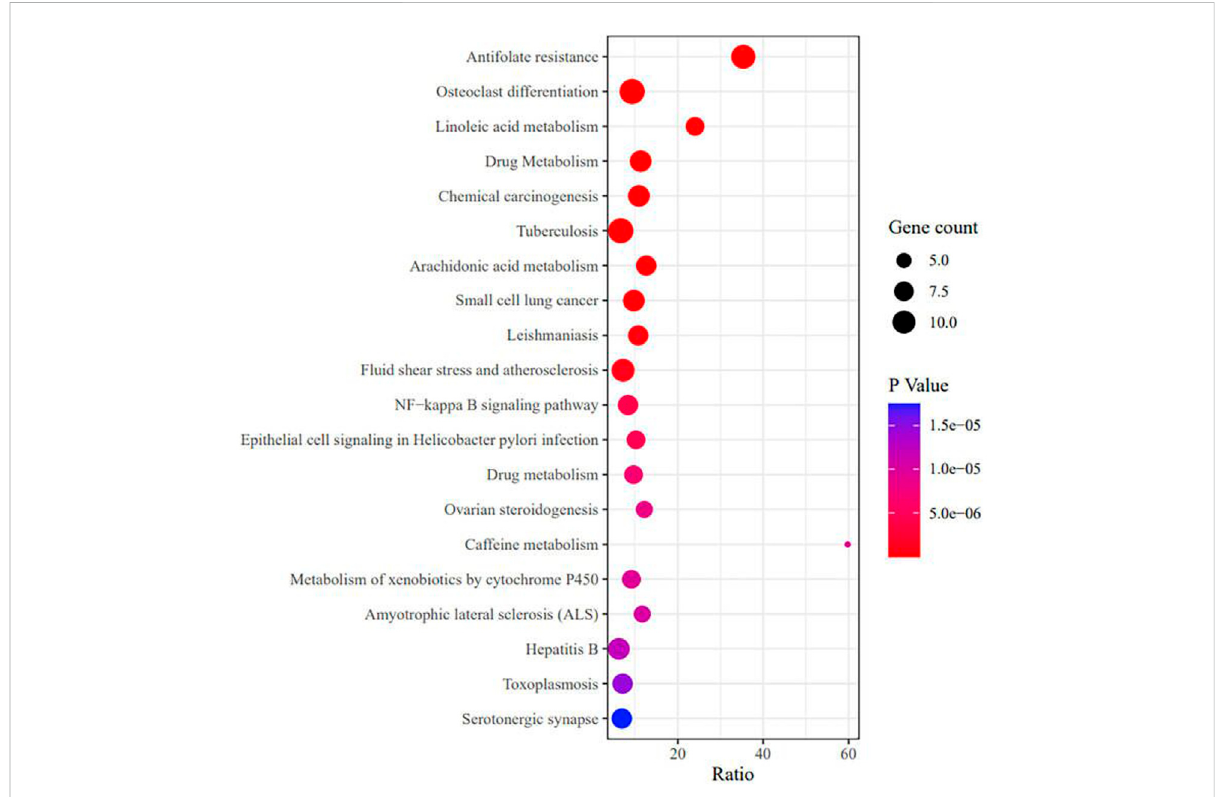
FIGURE 6 KEGG enrichment analysis of overlapping genes. The X-axis represents the gene enrichment rate, and the Y-axis represents the KEGG enrichment terms, p < 0.05.